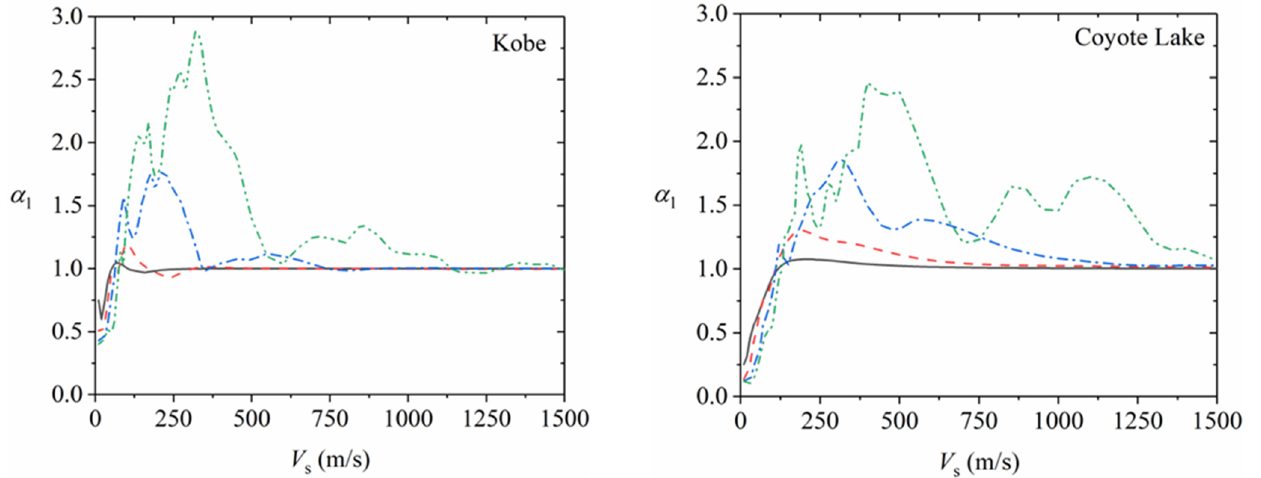
Figure 15. Ratio of the hydrodynamic shear under flexible soil to that under rigid soil for V s .